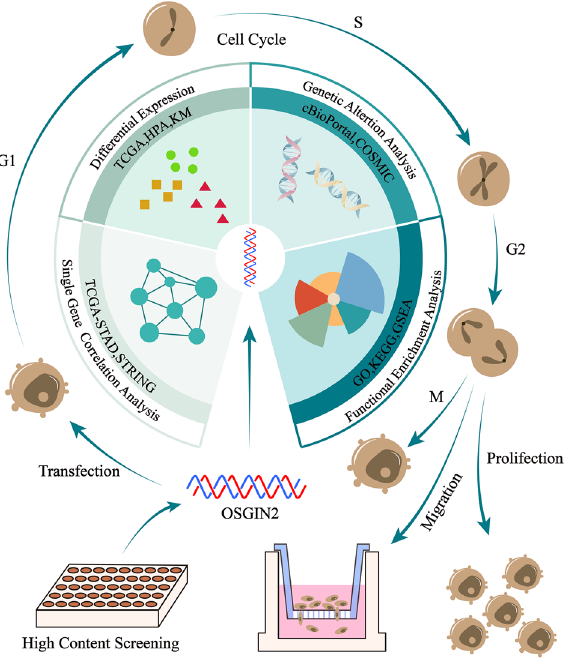
Figure 1. Clinical prognostic value of OSGIN2 in gastric cancer and its proliferative effect in